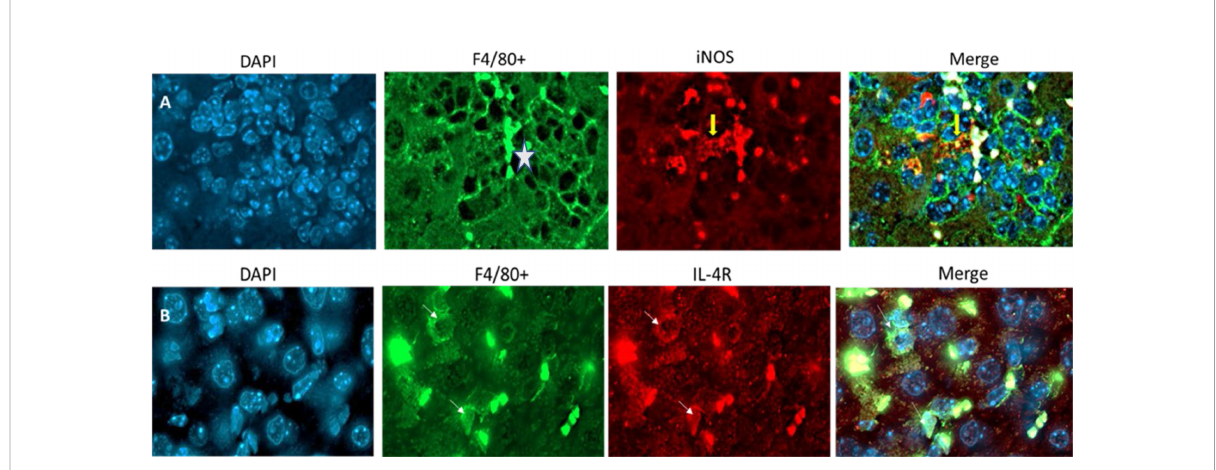
FIGURE 7 Macrophages within infected tissues display M1 marker restricted to granuloma and more widespread expression of M2 marker BALB/c mice were infected by tail vein injection with L. donovani parasites. At 20 days after infection, mice were sacri fi ced, and their liver recovered. The tissues were formalin- fi xed and then processed for immuno fl uorescence analyses of tissue sections. Sections from the infected were labeled with anti-F4/80 and either iNOS (A) or IL-4R (B) . Yellow arrow in A, points to speci fi c labeling of iNOS within a granuloma (white star is in the center of the granuloma). White arrows in B point to speci fi c Il-4R labeling. Images are representative of 3 mice in the infected